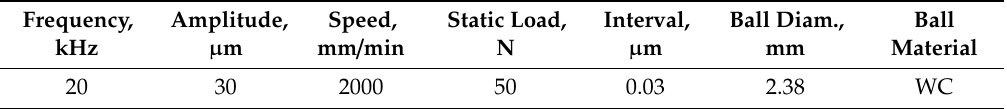
Table 4. UNSM treatment parameters.